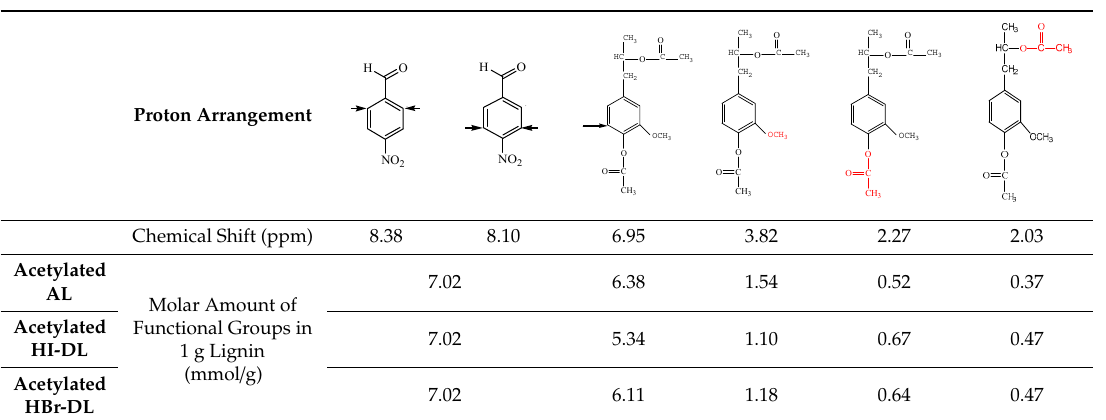
Table 2. Semi-quantitative comparison of phenolic and aliphatic hydroxyl groups after demethylation based on 1 H-NMR analysis of acetylated lignins.